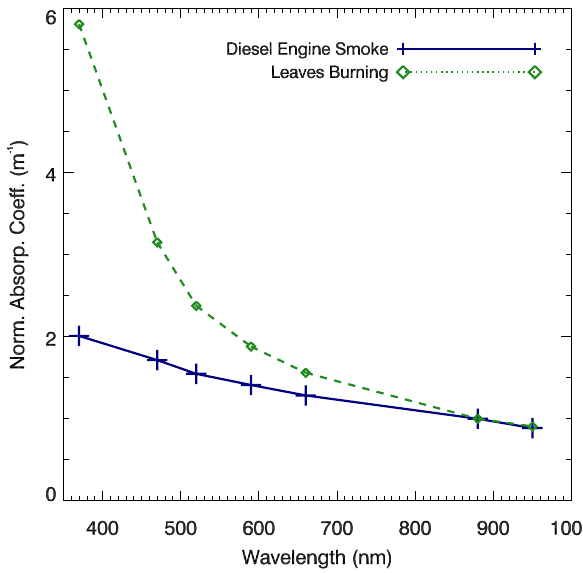
Fig. 1. Normalized absorption coefficient for two cases, one when diesel engine was running close to measurement site and another when leaf litter was burning. The values are normalized at